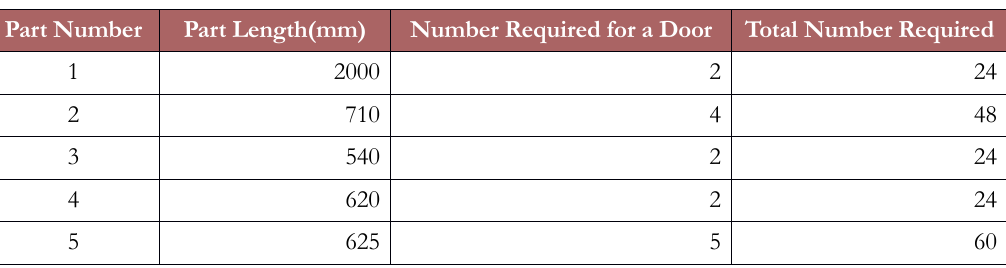
Table 2. Requirements of the Order